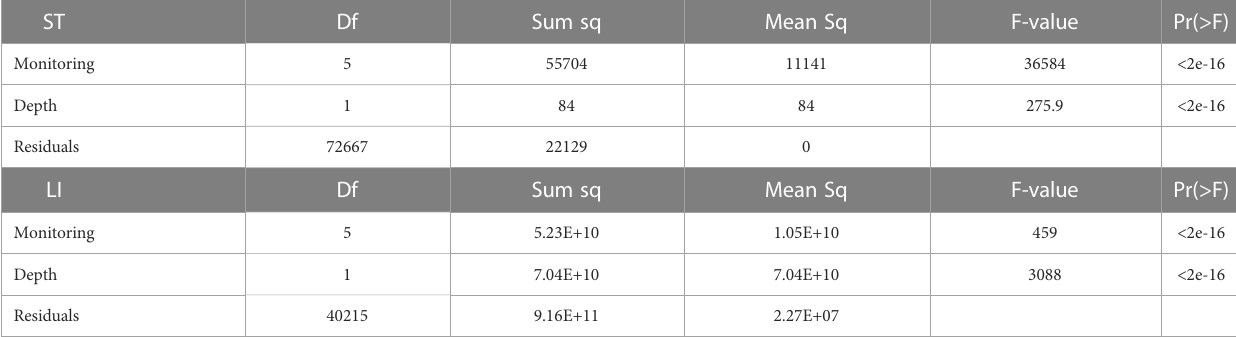
TABLE 1 Two-Way Repeated ANOVA analyses for water surface temperature (ST) and light intensity